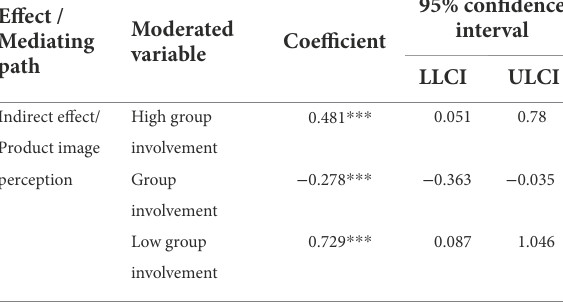
TABLE 5 Analysis results of cross-level moderated mediating effects.